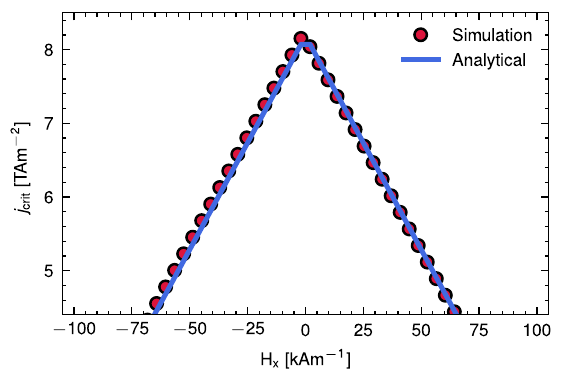
Fig. 7 Critical switching current densities as a function of external fi eld H x for Pt(4 nm)/Co(1 nm)/MgO SOT device. Fit to analytical formula is represented as a solid blue line and red dots depict the simulated result.